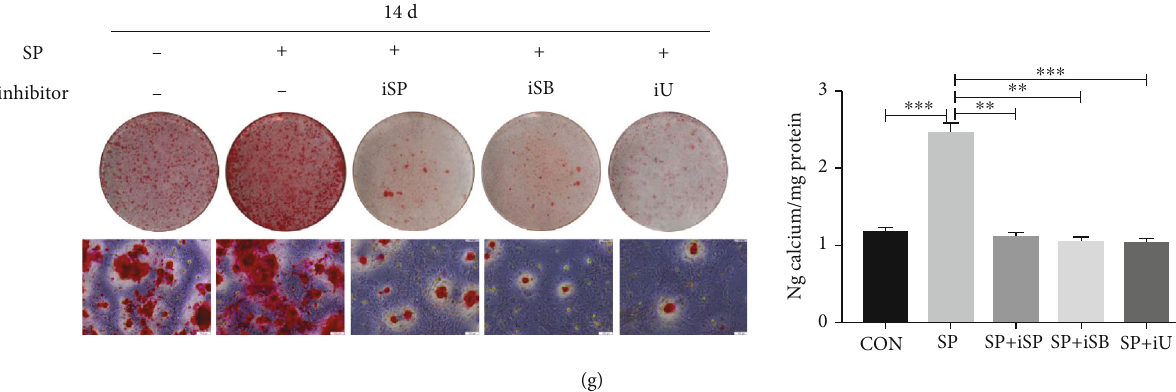
Figure 4: iRoot SP activated the MAPK cascades of BMSCs. (a) Protein titers of JNK, phospho-JNK, P38, p-p38, ERK, and p-ERK of SP- treated BMSCs and quantitative analysis of the ratios at di ff erent time points. ∗ p < : 05 , and ∗∗ p < : 01 . (b) The expression of MAPK-related proteins treated with cascade repressors (SP: SP600125, SB: SB203580, and U: U0126) was investigated by Western blot. ∗∗ p < : 01 , and ∗∗∗ p < : 001 . (c) Immuno fl uorescence staining of P-JNK, p-p38, and P-ERK after suppression of the MAPK cascades. Scale bar = 50 μ m . (d) Western blot assessment of osteo/odontogenic proteins in the di ff erent groups at day 7. Quantitative analysis of protein bands was performed using ImageJ. ∗ p < : 05 , ∗∗ p < : 01 , and ∗∗∗ p < : 001 . (e) MRNA expression of osteo/odontogenic di ff erentiation-associated genes was quanti fi ed by RT-PCR. ∗ p < : 05 , ∗∗ p < : 01 , and ∗∗∗ p < : 001 . (f) ALP staining and quanti fi cation of ALP enzyme activity of BMSCs cultured with complete medium, SP, SP +SB203580, SP +SP600125, and SP +U0126 for 5 days. Scale bar = 100 μ m . ∗∗ p < : 01 , and ∗∗∗ p < : 001 . (g) Alizarin Red S staining and quanti fi cation analysis of calcium nodules in the di ff erent groups at di ff erent time points. Scale bar = 100 μ m . ∗∗ p < : 01 , and ∗∗∗ p < : 001